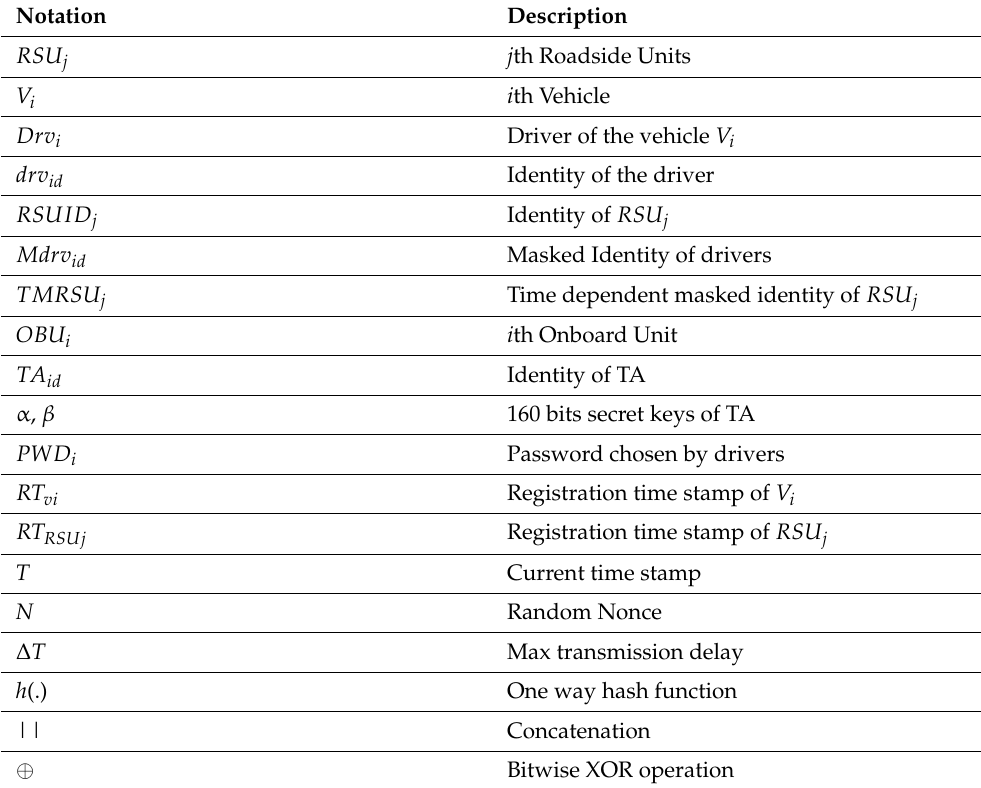
Table 1. Notations used in the